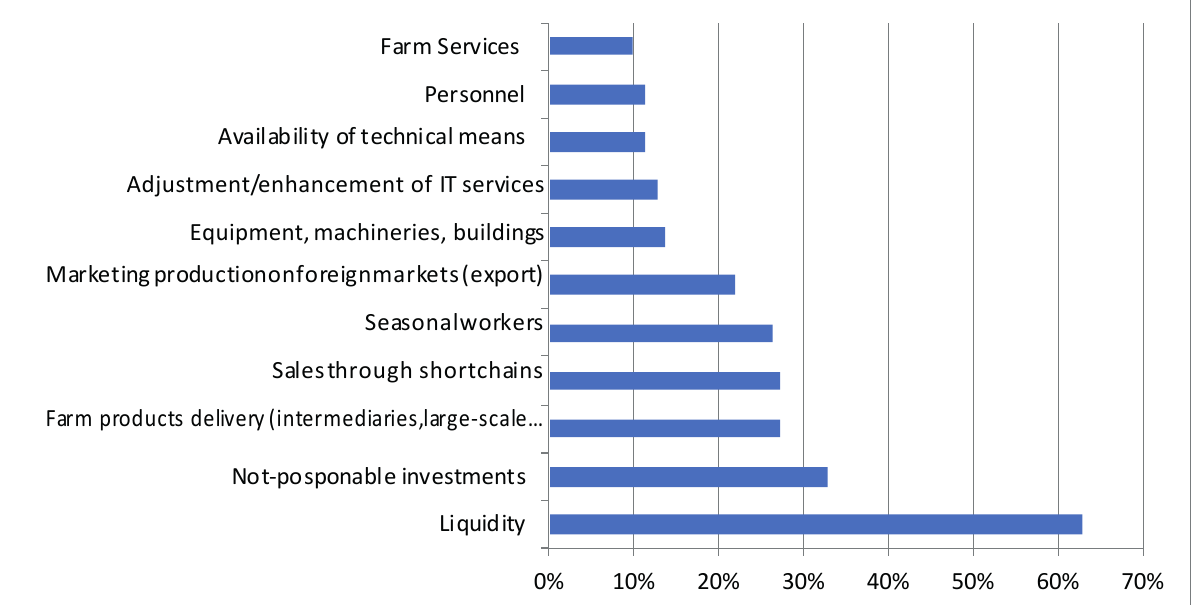
Figure 7. Diffi culties expected by surveyed farms in the months following the lockdown. Source: own elaboration on collected